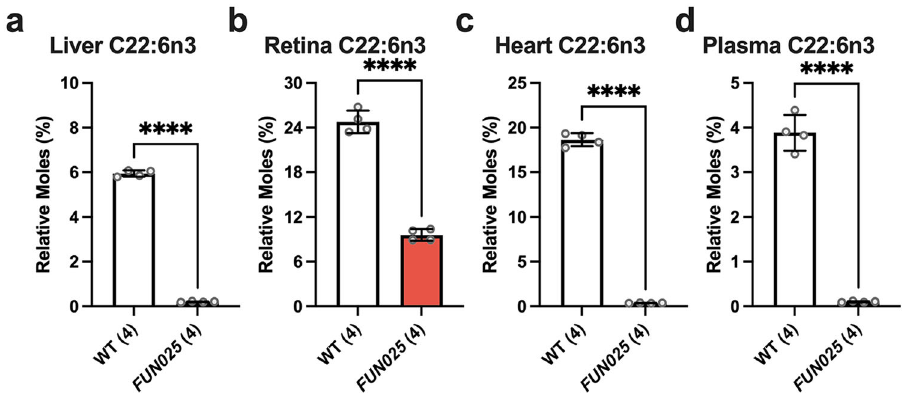
Fig. 2 Docosahexaenoic polyunsaturated fatty acid concentrations are reduced in Tmem135 mutant tissues. Bar graphs depicting relative moles of docosahexaenoic acid (DHA, C22:6n3) quanti fi ed by gas chromatography mass spectrometry (GC-MS) in four 2.5-month-old wildtype (WT) (3 male/1 Table S3. **** indicates P < 0.0001 signi fi cance by two-way Student ’ s t test. Number in parentheses represents the N of independent mouse samples per genotype used in the experiment. Dots represent individual data points. Data are presented as mean ±